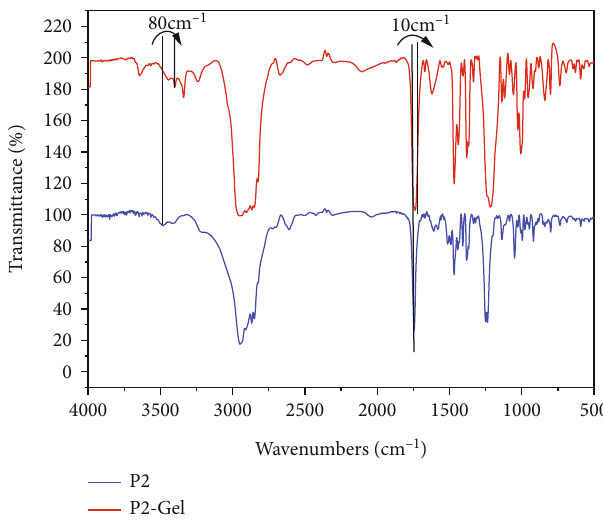
Figure 7: Infrared contrast spectra of P2 and P2-Gel.